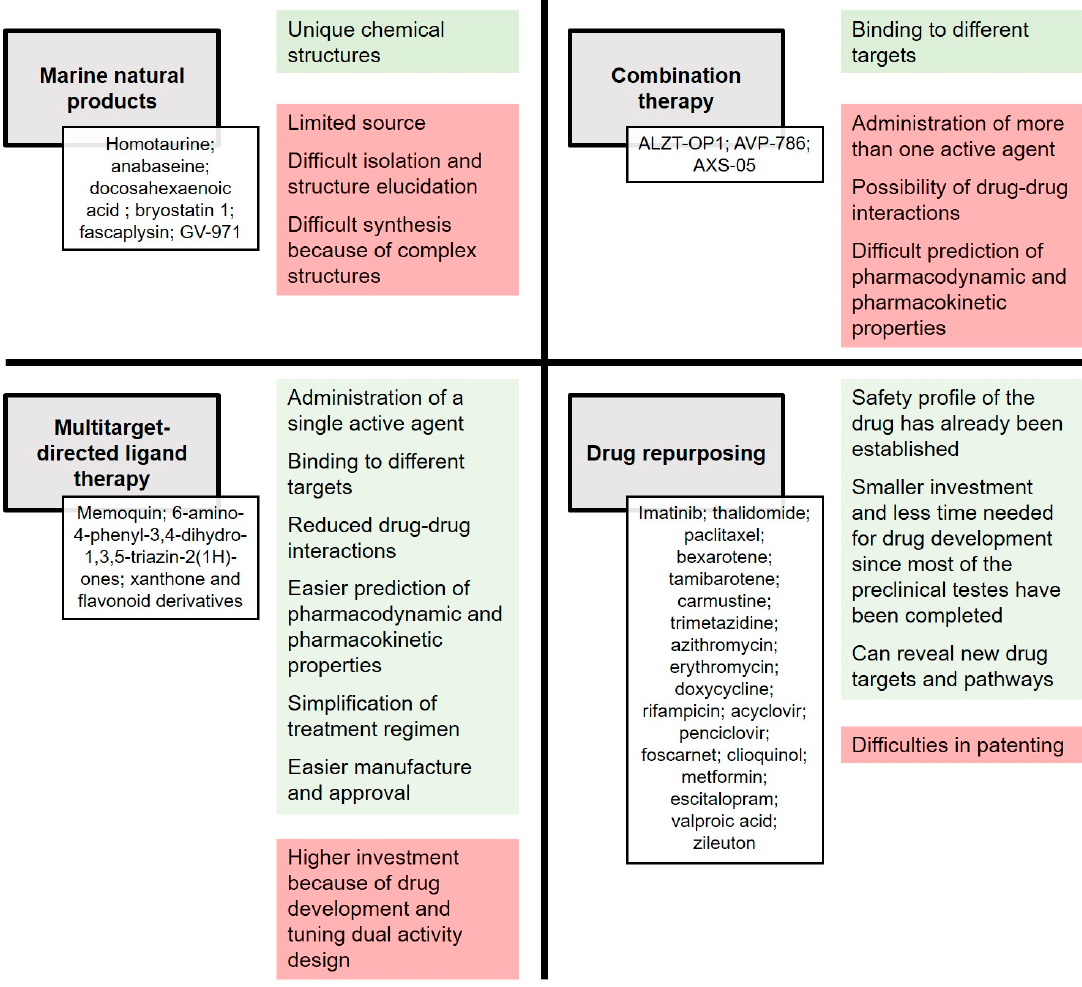
Figure 13. Advantages, in green, and disadvantages, in red, of the four drug discovery strategies addressed; marine natural products (MNP), combination therapy, multitargeted-directed ligand therapy (MTDL) and drug repurposing. In white are the mentioned agents with potential to become a drug candidate for AD treatment.